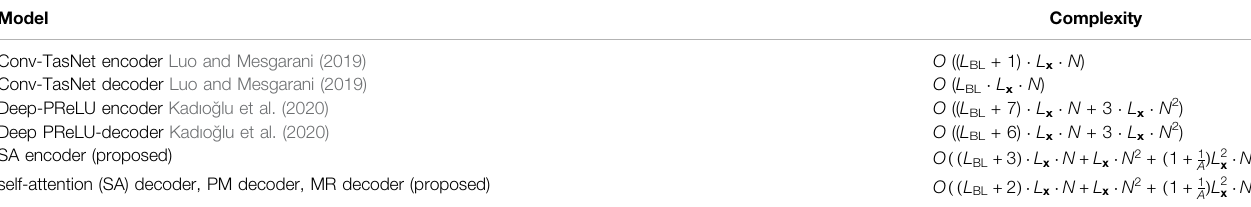
TABLE 1 | Complexity of all encoder and decoder models evaluate including all non-linearities, weights and biases. Model Conv-TasNet encoder Luo and Mesgarani